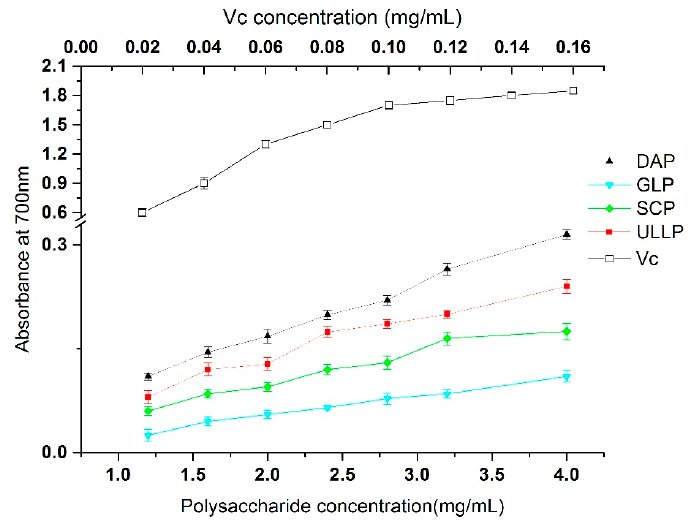
Figure 7. Reducing power of GLP, DAP, ULLP, SCP, and Vc. GLP, DAP, SCP, and SCP are polysaccharides extracted from G. lemaneiformis , D. antarctica , S. ceylonensis , and Ulva lactuca L., respectively.